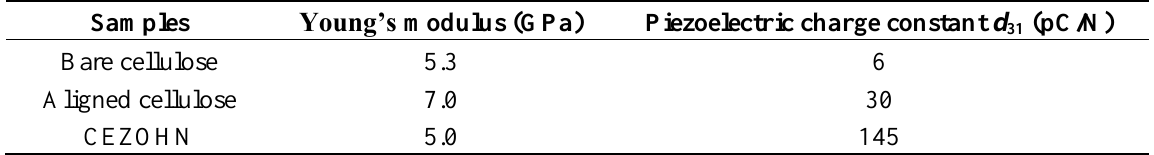
Table 1. Comparison of Young’s modulus and piezoelectric charge constant of cellulose and CEZOHN.